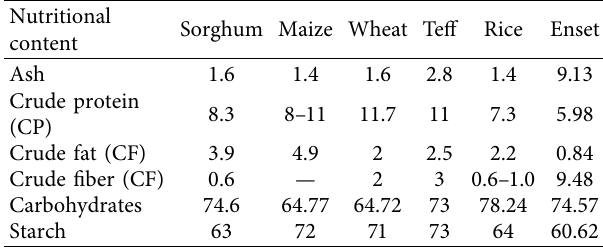
Table 1: Nutritional composition of sorghum crop grain compared to other crops.